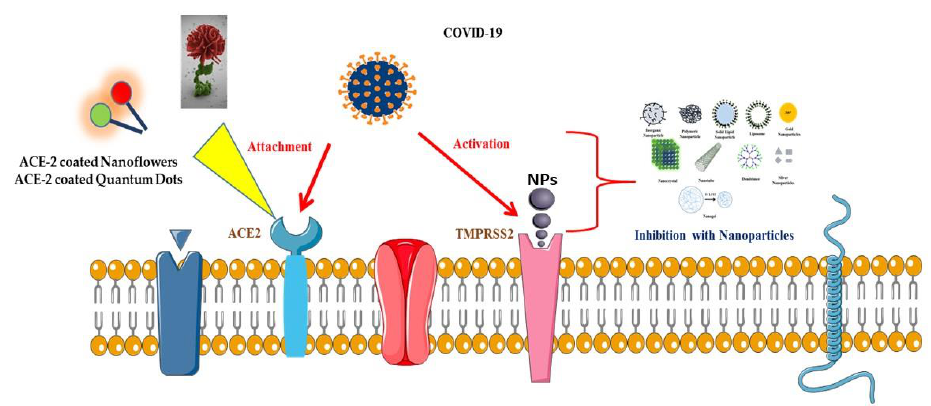
Figure 4. Hypothetical model illustrating the entry of SARS-CoV-2 into a host cell and its pathogenicity. SARS-CoV-2 spike (S) proteins bind to ACE2 receptors and then the virus enters and infects host cells. ACE2 activation may be blocked by ACE2-coated nanoflowers and ACE2-coated quantum dots. Nanoparticles (NPs) may prevent or reduce the activation/expression of the cellular protease TMPRSS2, which primes the S proteins, potentially suppressing SARS-CoV-2 infection.